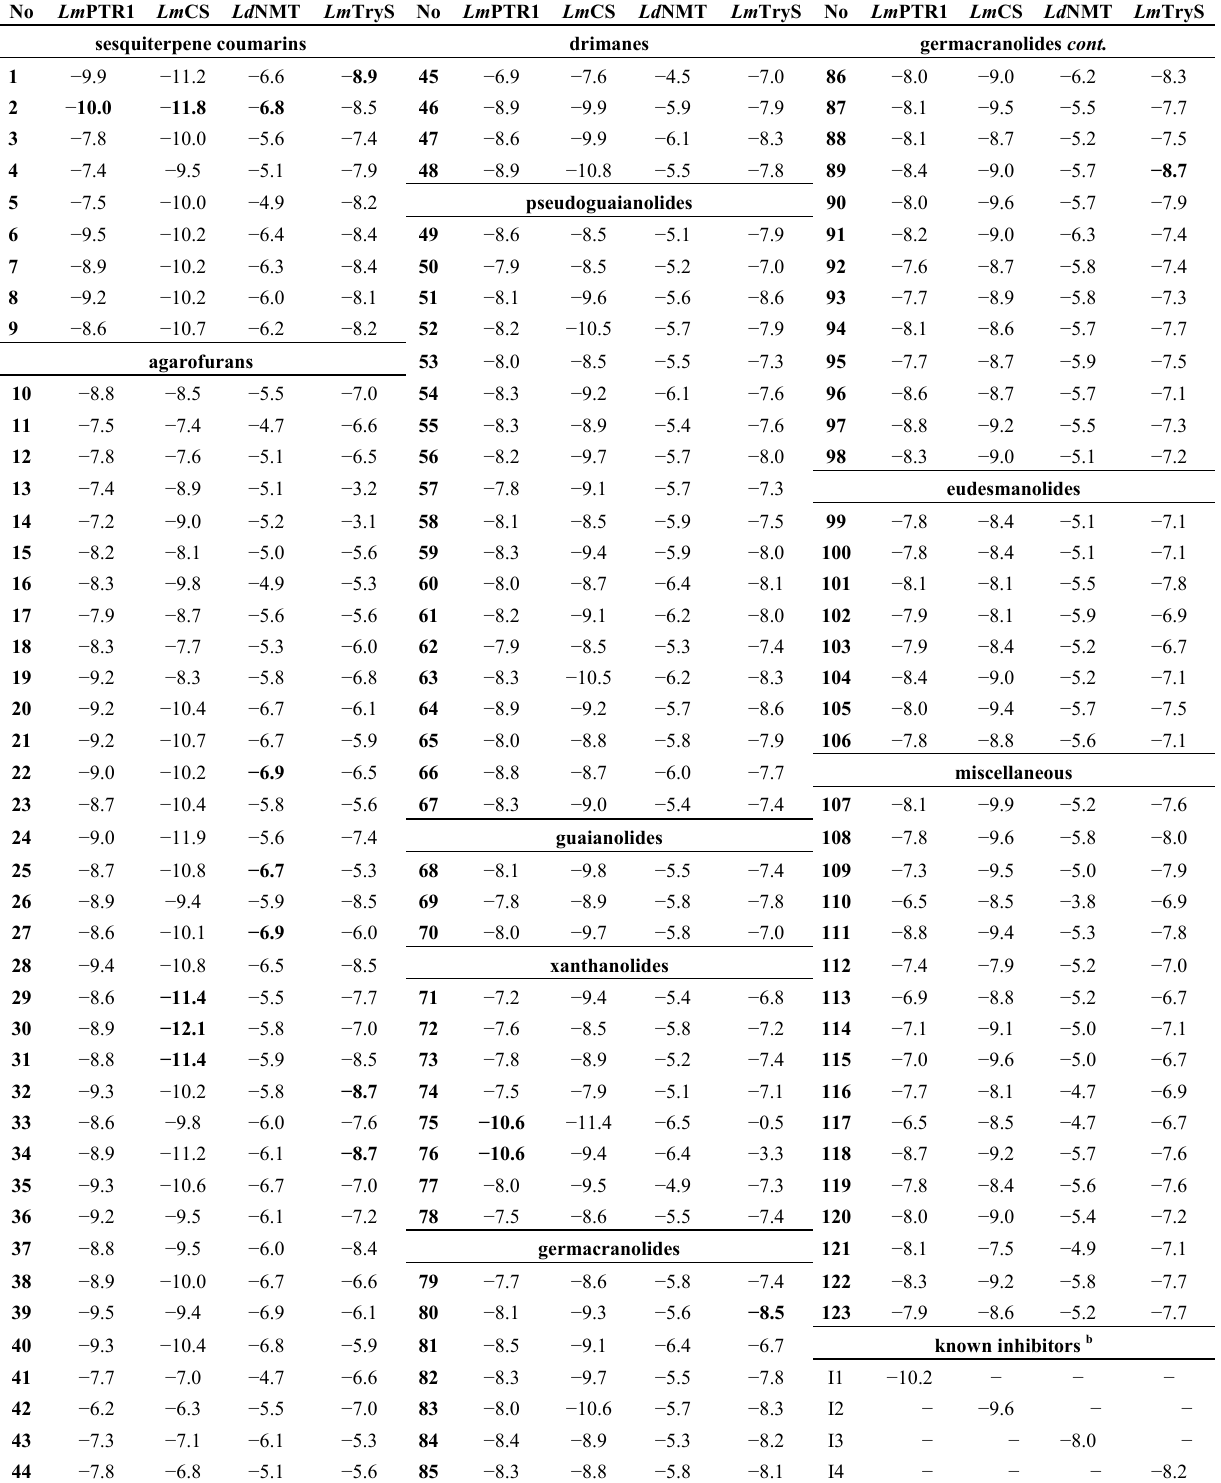
Table 2. Docking energies a (kcal/mol) of sesquiterpenoids with Leishmania enzyme